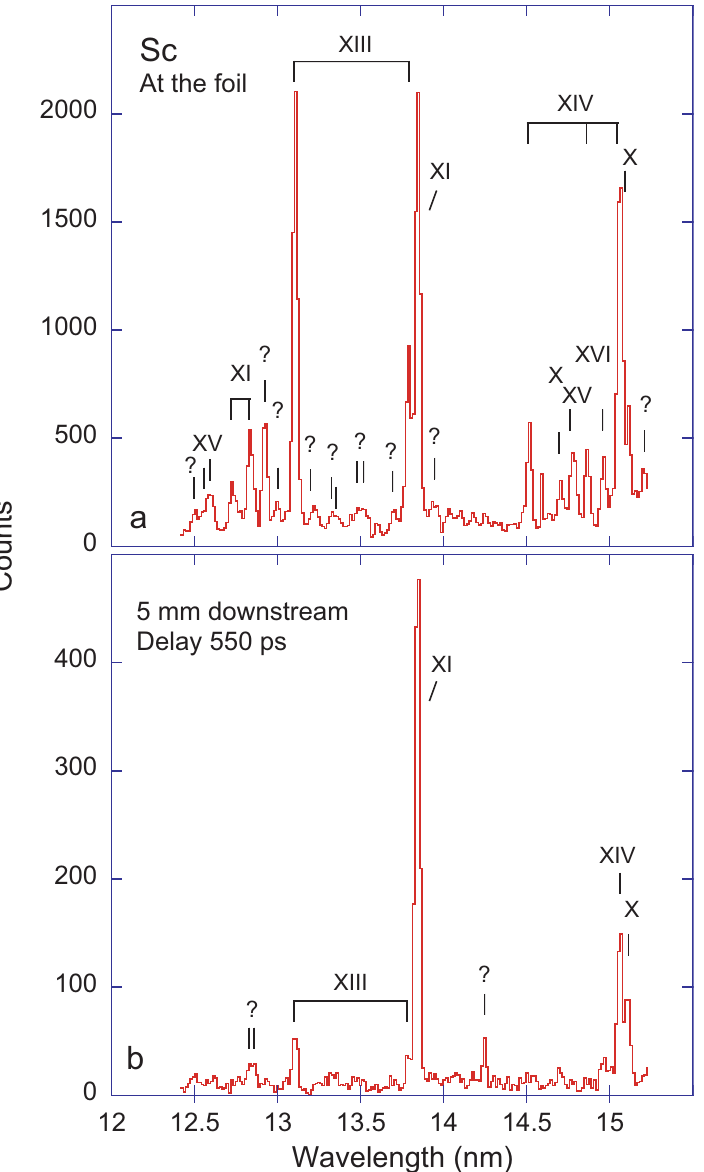
Figure 1. Beam-foil spectra of Sc at an ion beam energy of 19MeV. Line width (full width at half maximum (FWHM)) 0.038nm. The strongest lines are identified by the spectrum number. Unidentified lines are marked by a fiducial with a question mark. The charge state distribution peaks at q = 11 + , and ion charge states q = 8 + to q = 14 + are expected to contribute. ( a ) Observation at the foil and ( b ) observation of the ion beam 5mm downstream of the foil, corresponding to a delay of 550ps after the spectrum in subfigure ( a